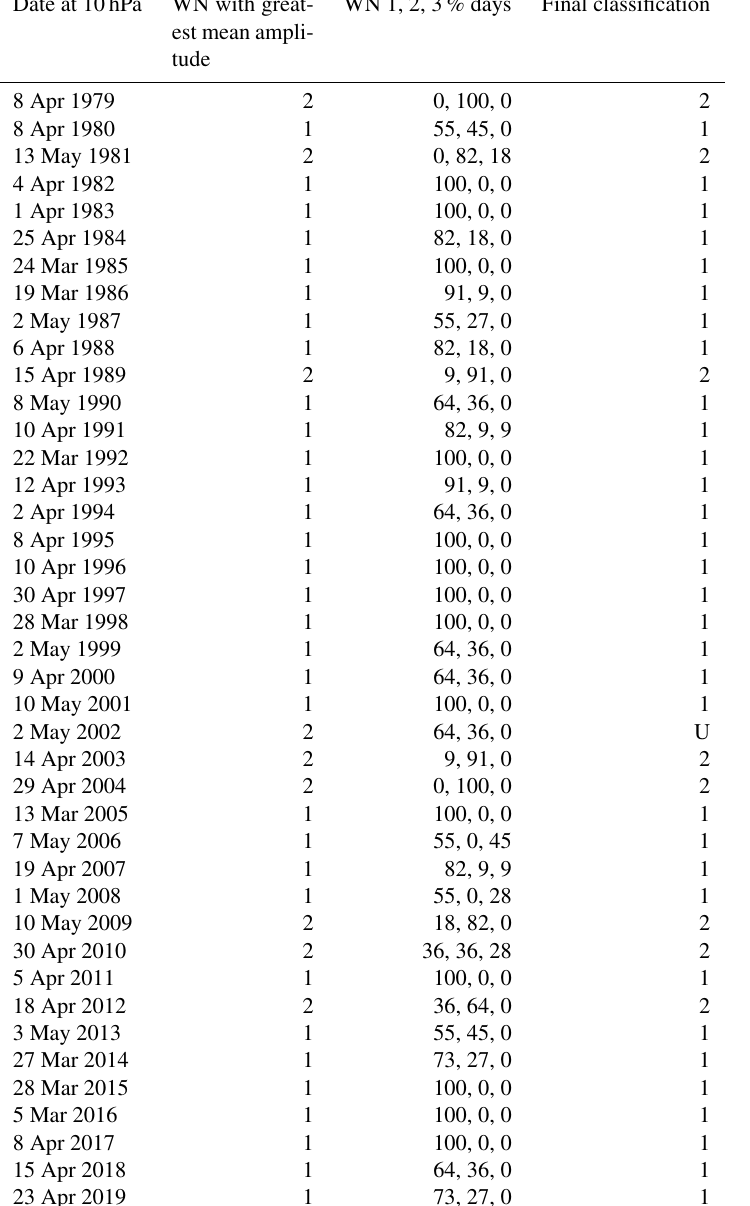
Table A1. Details of JRA-55 classification for 1979–2019 using NH final warming dates based on 60 ◦ N and 10hPa. The two metrics determine the wavenumber (WN) with maximum mean amplitude and highest percent of days of maximum amplitude for the 10d before the FSW, as described in Sect. 2. U = unclassified (methods did not agree according to the criterion outlined in Sect.